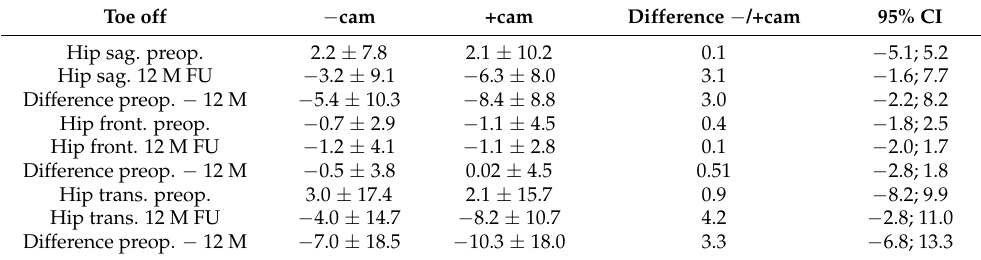
Table 3. Mean values and standard deviations at the toe off of the treated hip before and 12 months after surgery, as well as the difference between both time points depending on the presence of a cam deformity. No statistically significant differences were found. The mean differences between the hip angles in patients with and without a cam deformity ranged between 0.1–4.2 ◦